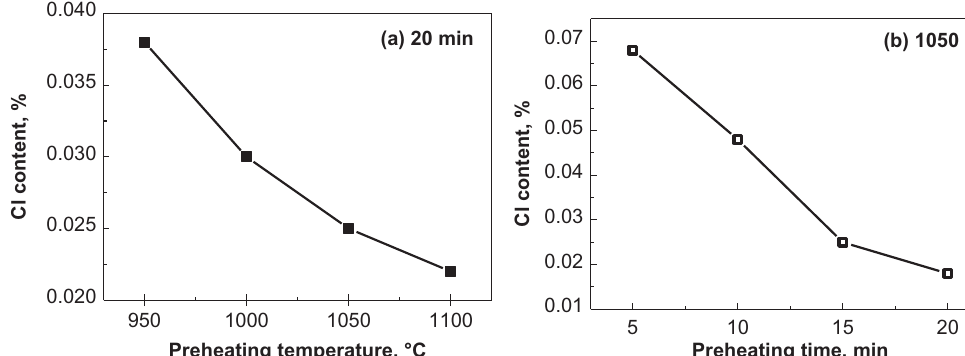
Figure 5: Effects of preheating on residual Cl content.